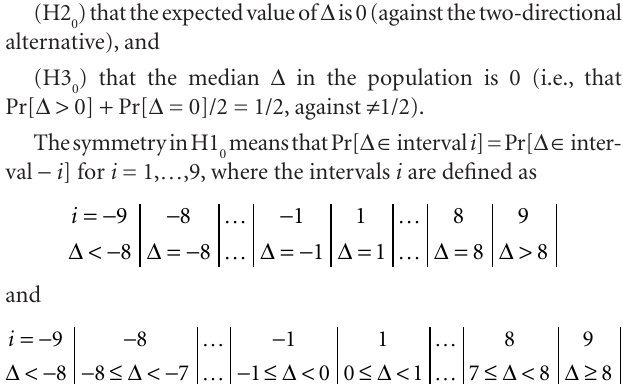
ments and 2, 4, 6, … for the left ones), the ordinate axis of the inset